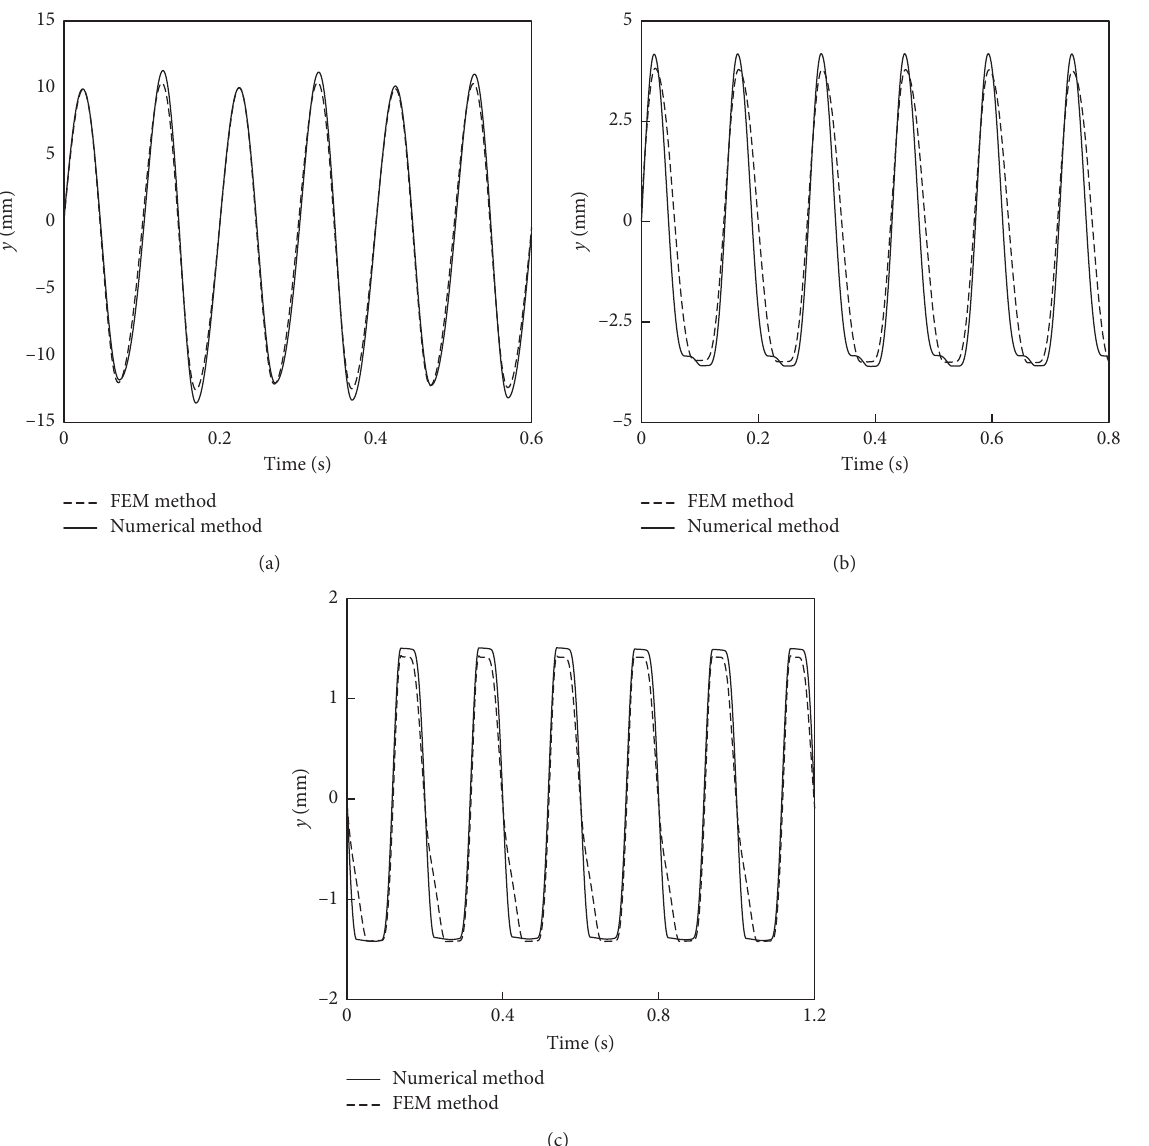
Figure 11: The time-domain curves of displacement of the numerical method and FEM method for different excitation frequencies. (a) 10Hz. (b) 7Hz. (c)